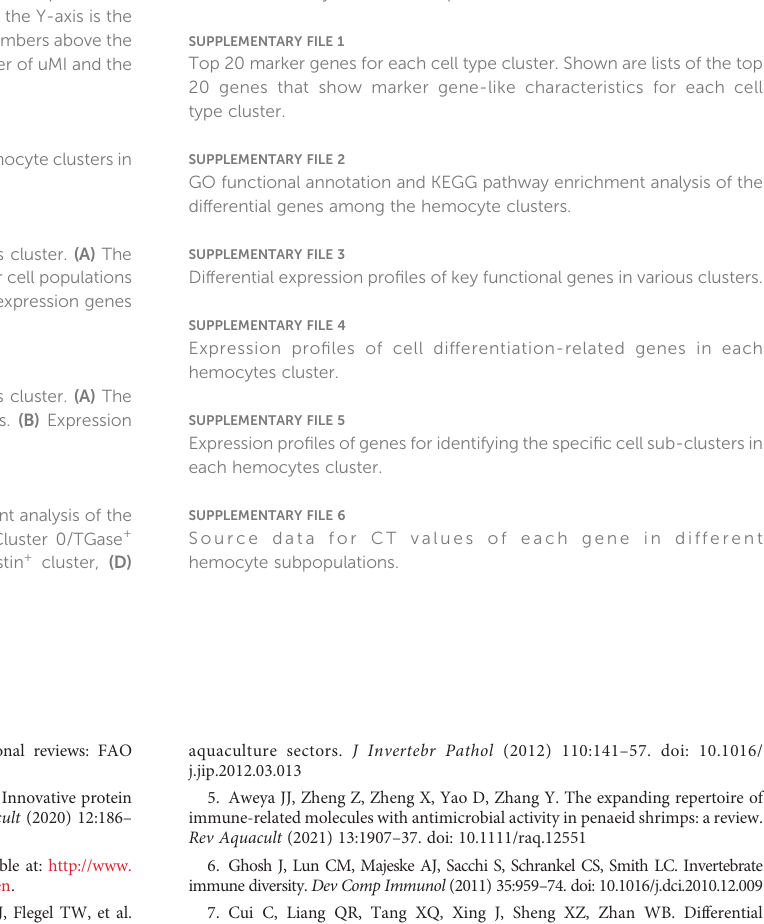
hemocytes cluster. (A) Heatmap showing the expression of genes related to the NOTCH signaling pathway among various clusters. (B – D ) Differential expression of genes related to cell differentiation among cell clusters. SUPPLEMENTARY FIGURE 7 Statistics on the number and percentage of different sub-clusters in each hemocyte cluster. (A) Cluster 0/TGase + cluster, (B) Cluster 1/CTL + cluster, (C) Cluster 2/Crustin + cluster SUPPLEMENTARY FIGURE 8 Identi fi cation of speci fi c cell sub-clusters. (A) TGase + cluster. (B) CTL + cluster. (C) Crustin + cluster. SUPPLEMENTARY FIGURE 9 Schematic showing the functional characteristics of hemocytes morphological subpopulations, and their potential lineage fl ow based on hemocyte cluster pro fi les. (A) Schematic plot shows the functional characteristics of hemocytes morphological subpopulations. (B) The potential lineage fl ow of hemocytes morphological subpopulations. (C) The potential lineage fl ow of hemocytes morphological subpopulations based on hemocyte sub-cluster pro fi les. SUPPLEMENTARY FILE 1 Top 20 marker genes for each cell type cluster. Shown are lists of the top 20 genes that show marker gene-like characteristics for each cell type cluster. SUPPLEMENTARY FILE 2 GO functional annotation and KEGG pathway enrichment analysis of the differential genes among the hemocyte clusters. SUPPLEMENTARY FILE 3 Differential expression pro fi les of key functional genes in various clusters. SUPPLEMENTARY FILE 4 Expression pro fi les of cell differentiation-related genes in each hemocytes cluster. SUPPLEMENTARY FILE 5 Expression pro fi les of genes for identifying the speci fi c cell sub-clusters in each hemocytes cluster. SUPPLEMENTARY FILE 6 Source data for CT values of each gene in different hemocyte